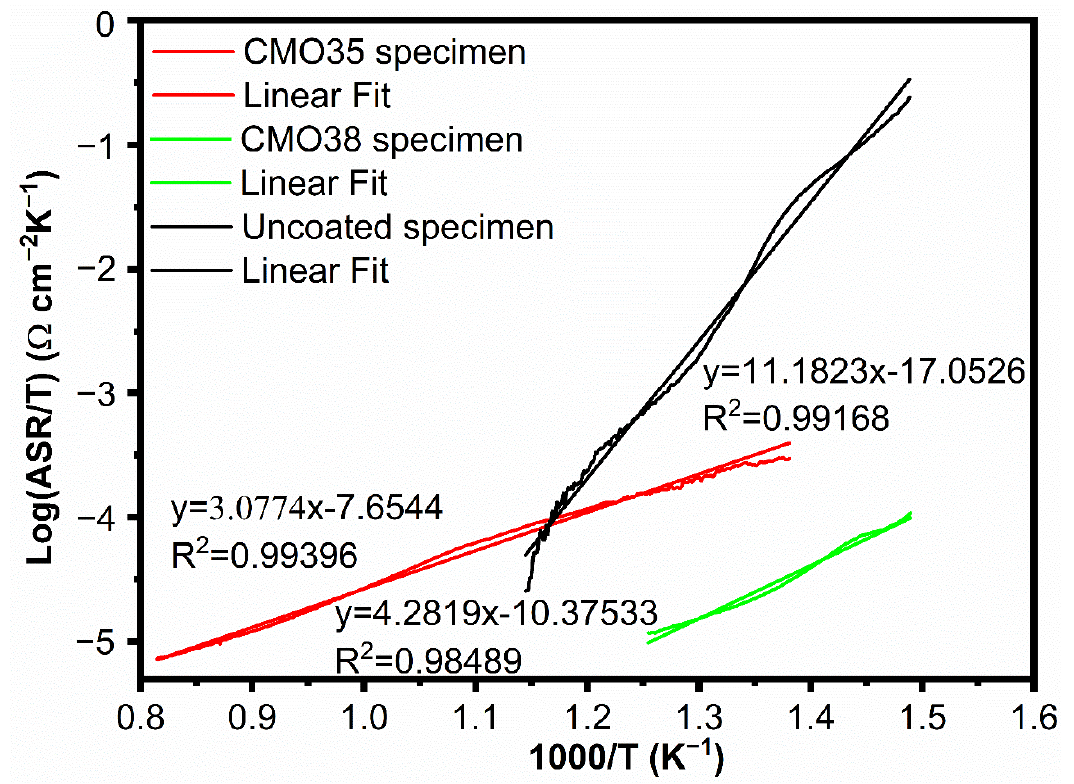
Figure 8. The temperature dependence of the ASR of the coated and uncoated specimens (CoMnO30, CoMnO35, CoMnO38) under a simulated O-electrode environment.